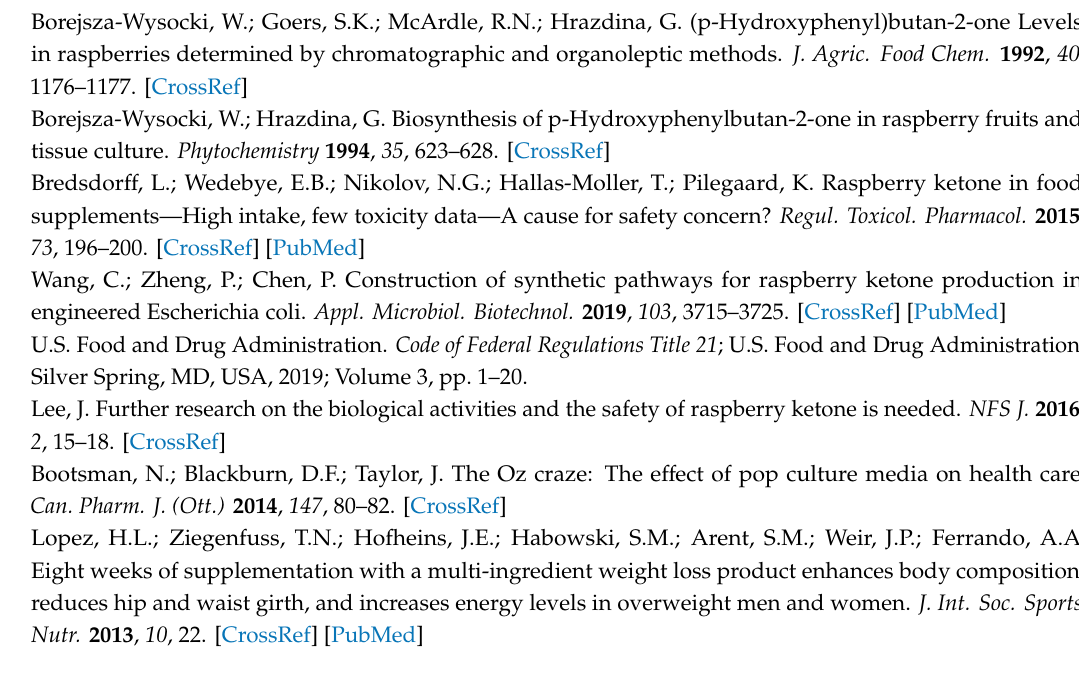
Figure S1: Experimental design for measurement of meal patterns and behavioral outcomes during exposure to respective diet and dose treatments. Figure S2: Experimental design for measurement of hemodynamic parameters after 14-day exposure to respective diet and dose treatments. Figure S3: Experimental design to study activation of caudal hindbrain in response to respective diet and dose